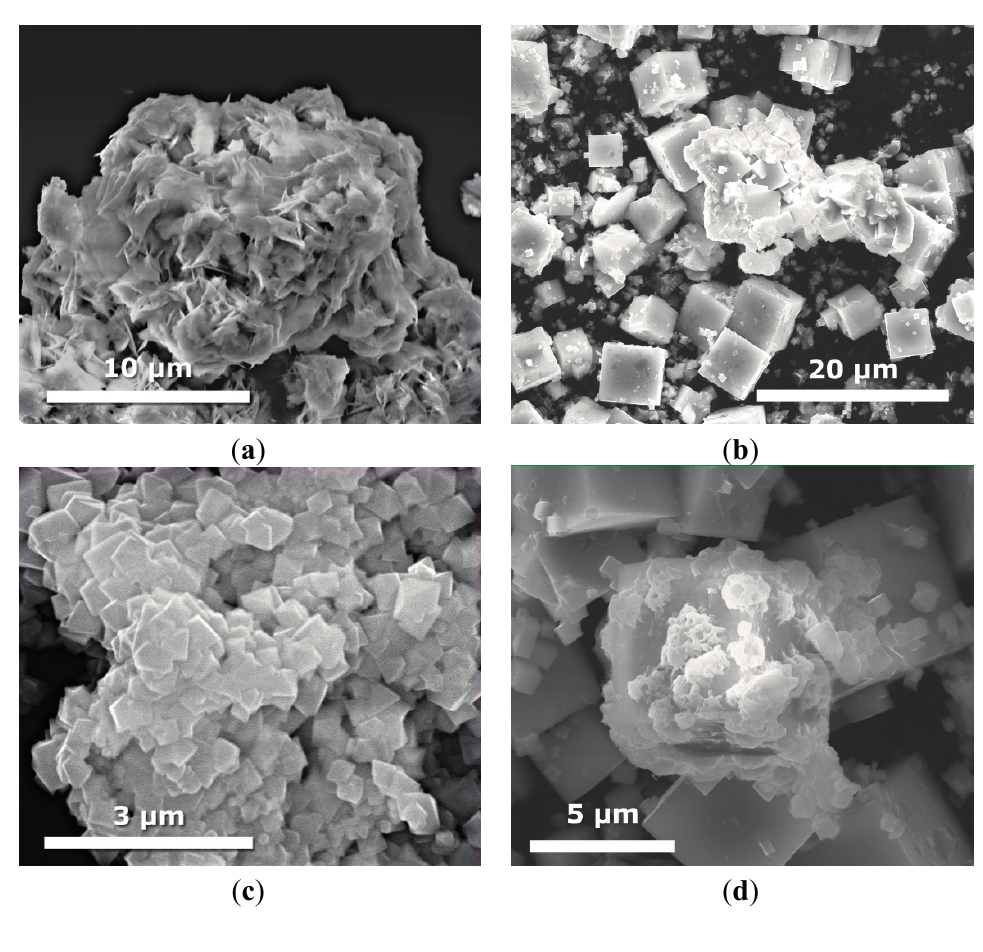
Figure 4. SEM images of binary KTaO 3 -CdS and KTaO 3 -MoS 2 composites obtained with different molar ratio and using two preparation routes: ( a ) KTaO 3 -CdS (10:1) obtained by solvothermal mixed solutions (sample KTaO 3 -CdS 10-1_MS); ( b ) KTaO 3 -CdS (10:1) obtained by calcination of single previously synthesized semiconductors (sample KTaO 3 -CdS 10-1_C); ( c ) KTaO 3 -MoS 2 (10:1) obtained by solvothermal mixed solutions (sample KTaO 3 -MoS 2 10-1_MS); and ( d ) KTaO 3 -MoS 2 (10:1) obtained by calcination of single previously synthesized semiconductors (sample KTaO 3 -MoS 2